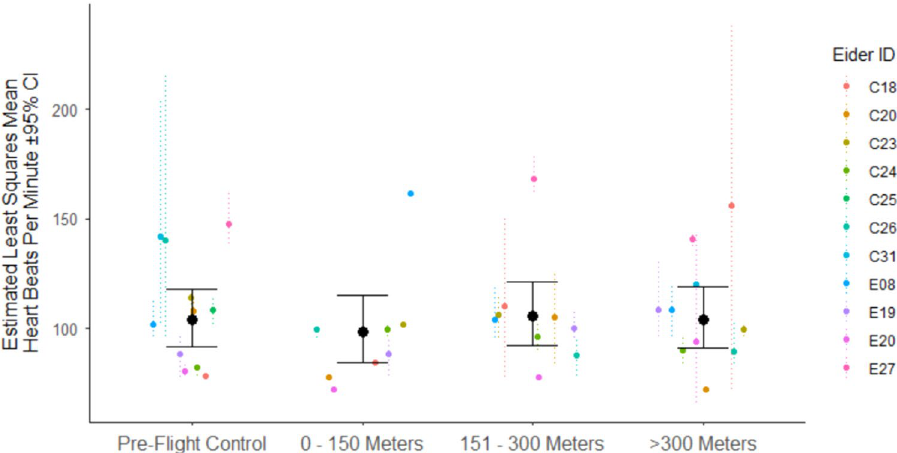
Figure 2. Data scale model estimates for Common eider ( Somateria mollissima ) mean heart rates (bpm) in each distance category (± 95% confidence intervals). Dashed, coloured lines indicate mean and range of raw heart-rate data for individual eiders. Note that points without range bars indicate only a single data point for that individual within that category. Ranges jittered for